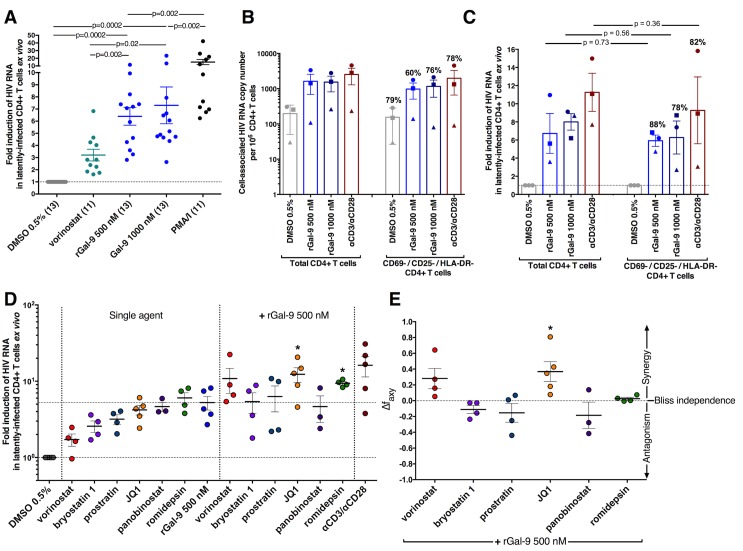
rGal-9 is a potent mediator of HIV transcription ex vivo and synergizes with JQ1 in reactivating latent HIV.(A) Treatment of CD4+ T cells isolated from ART-suppressed HIV-infected individuals with DMSO 0.5% (negative control), PMA/ionomycin (2 nM / 500 nM), vorinostat (1μM), or varying concentrations of rGal-9 (500 nM and 1000 nM) for 24 hours. Fold increase in cell-associated HIV RNA was determined relative to the corresponding DMSO-treated control for each individual time point. Mean ± SEM is displayed, and statistical comparisons between rGal-9 and other treatments were performed using two-tailed paired Wilcoxon signed-rank tests. (B-C) CD4+ T cells were isolated from PBMCs of three HIV-infected ART-suppressed individuals using negative selection. Resting CD4+ T cells were further enriched through depletion of cells expressing CD69, CD25, or HLA-DR surface markers from half of the isolated CD4+ T cells. The remaining half was processed through the exact enrichment procedure, except PBS was added instead of the depleting antibodies. Both cell populations were treated with 0.5% DMSO (negative control), 500 nM rGal-9, 1000 nM rGal-9 or αCD3/αCD28-conjugated beads. Induction of cell-associated HIV RNA was measured 24 hours post-treatment using RT-qPCR. Each individual is represented with a different symbol. Mean ± SEM is displayed, and statistical comparisons were performed using two-tailed paired t tests. Percentages reported reflect average values measured in the CD69- / CD25- / HLA-DR- CD4+ T cells with respect to values observed in total CD4+ T cells. (D) CD4+ T cells from HIV-infected ART-suppressed individuals were treated with 500 nM of rGal-9, 1 μM vorinostat, 40 nM romidepsin, 10 nM bryostatin, 300 nM prostratin, 1 μM JQ1, or 30 nM panobinostat alone or in combination with 500 nM of rGal-9 for 24 hours, and fold induction of cell-associated HIV RNA was determined using quantitative real-time PCR. * = p<0.05 compared with rGal-9 500 nM treatment alone. (E) The Bliss independence model was utilized for calculation of synergy for drug combinations. Δfaxy = 0 signifies a pure additive effect. Δfaxy>0 signifies synergy, while Δfaxy<0 signifies antagonism. Statistical significance was calculated using a two-tailed paired t-test comparing predicted and observed drug combination effects. * = p < 0.05.